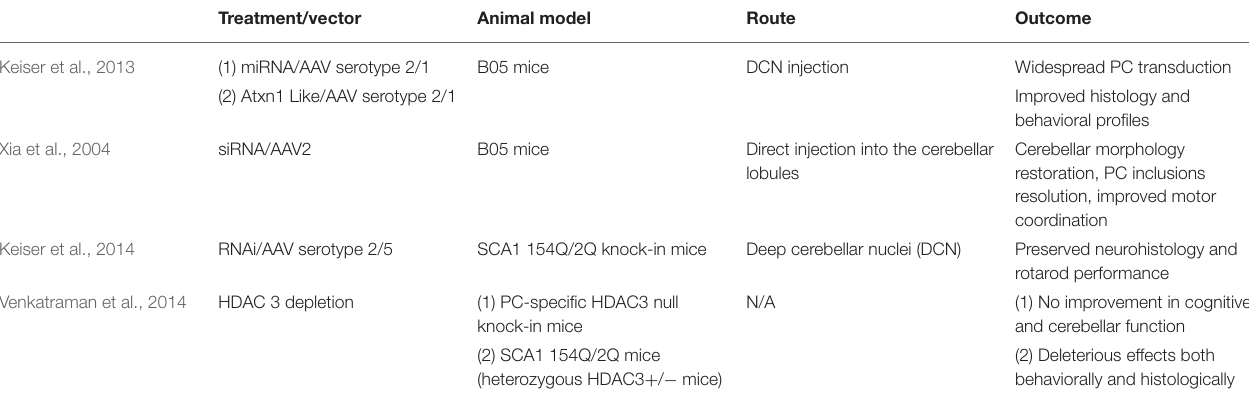
TABLE 3 | Overview of gene therapies for SCA